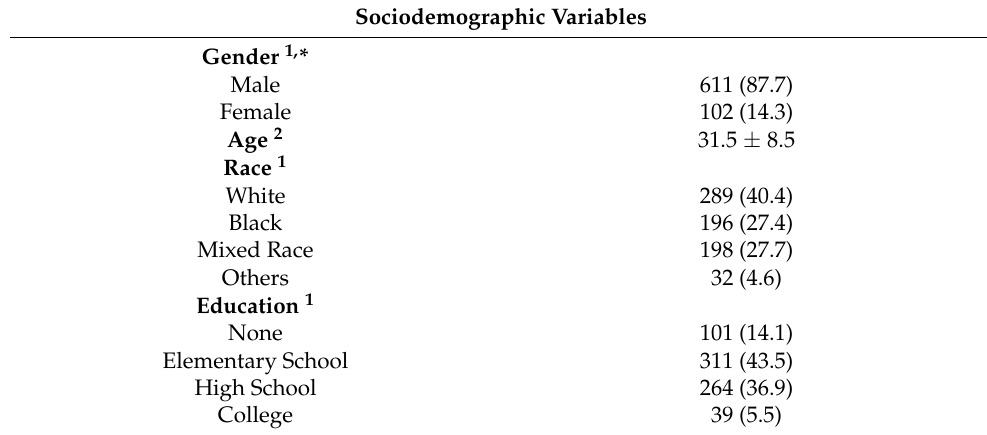
Table 1. The sociodemographic variables of crack cocaine users in outpatient treatment units in six Brazilian